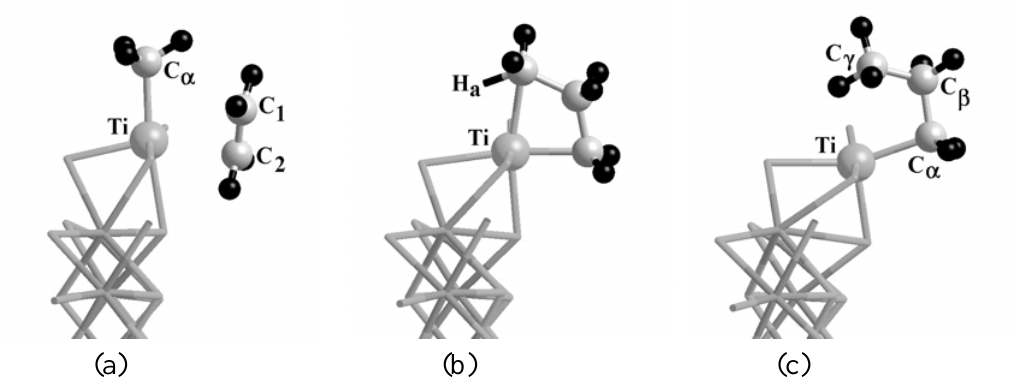
Figure 5. The main phases of the ethylene insertion process: the π -complex (a), the transition state (b) and the final product (c). The reaction coordinate is the distance between C the H atom that gives rise to the agostic interaction with Ti. H atoms of the olefin and the polymer chain are evidenced for clarity as black